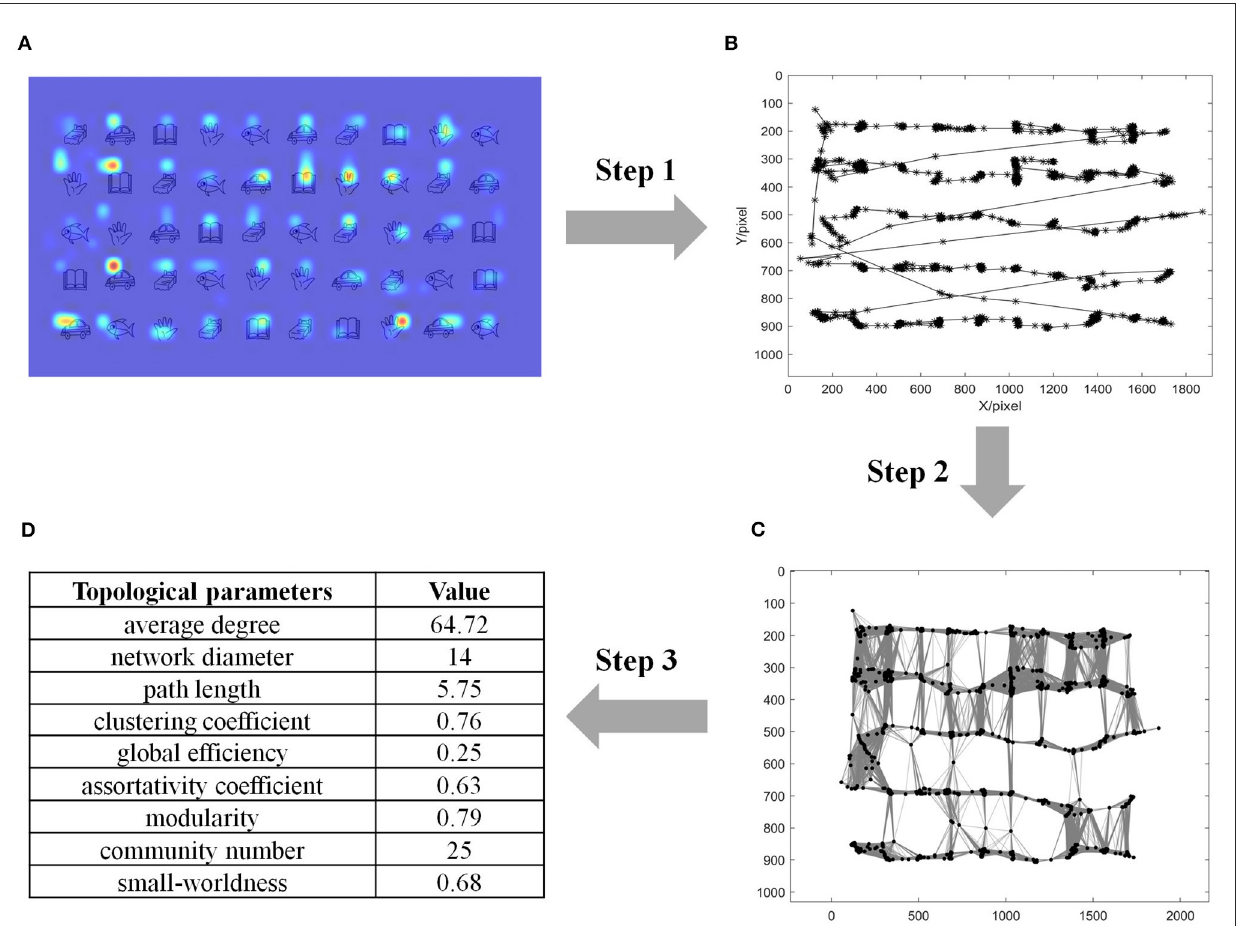
FIGURE2 Method, involving three steps, to construct the gaze-time-series complex network (GCN) in an illustrating example of a child during a RAN task. (A) Heatmap of gazes in the illustrating example; (B) Raw spatial coordinate of eye gazes in the illustrating example, where two adjacent gazes were linked by a straight line; (C) The network connectivity of GCN in the illustrating example, where dots represented nodes and black lines represented connections between nodes; (D) Topological properties analysis and their values in the illustrating example. RAN, Rapid automatized